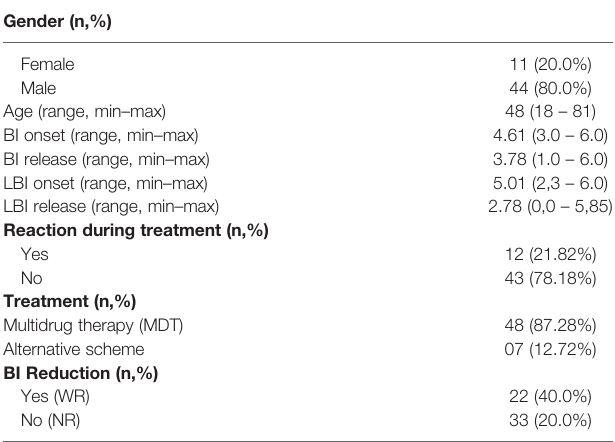
TABLE 1 | Demographic and clinical data of patients included in the study (n =